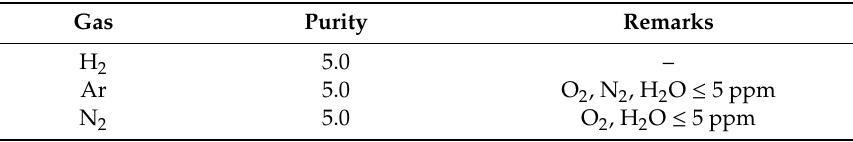
Table 3. Qualities of the gases used for the trials.